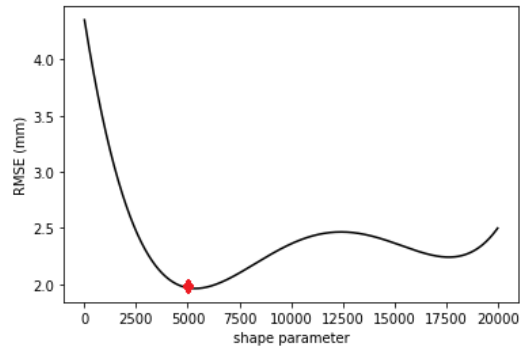
Figure 4. Determination of the shape